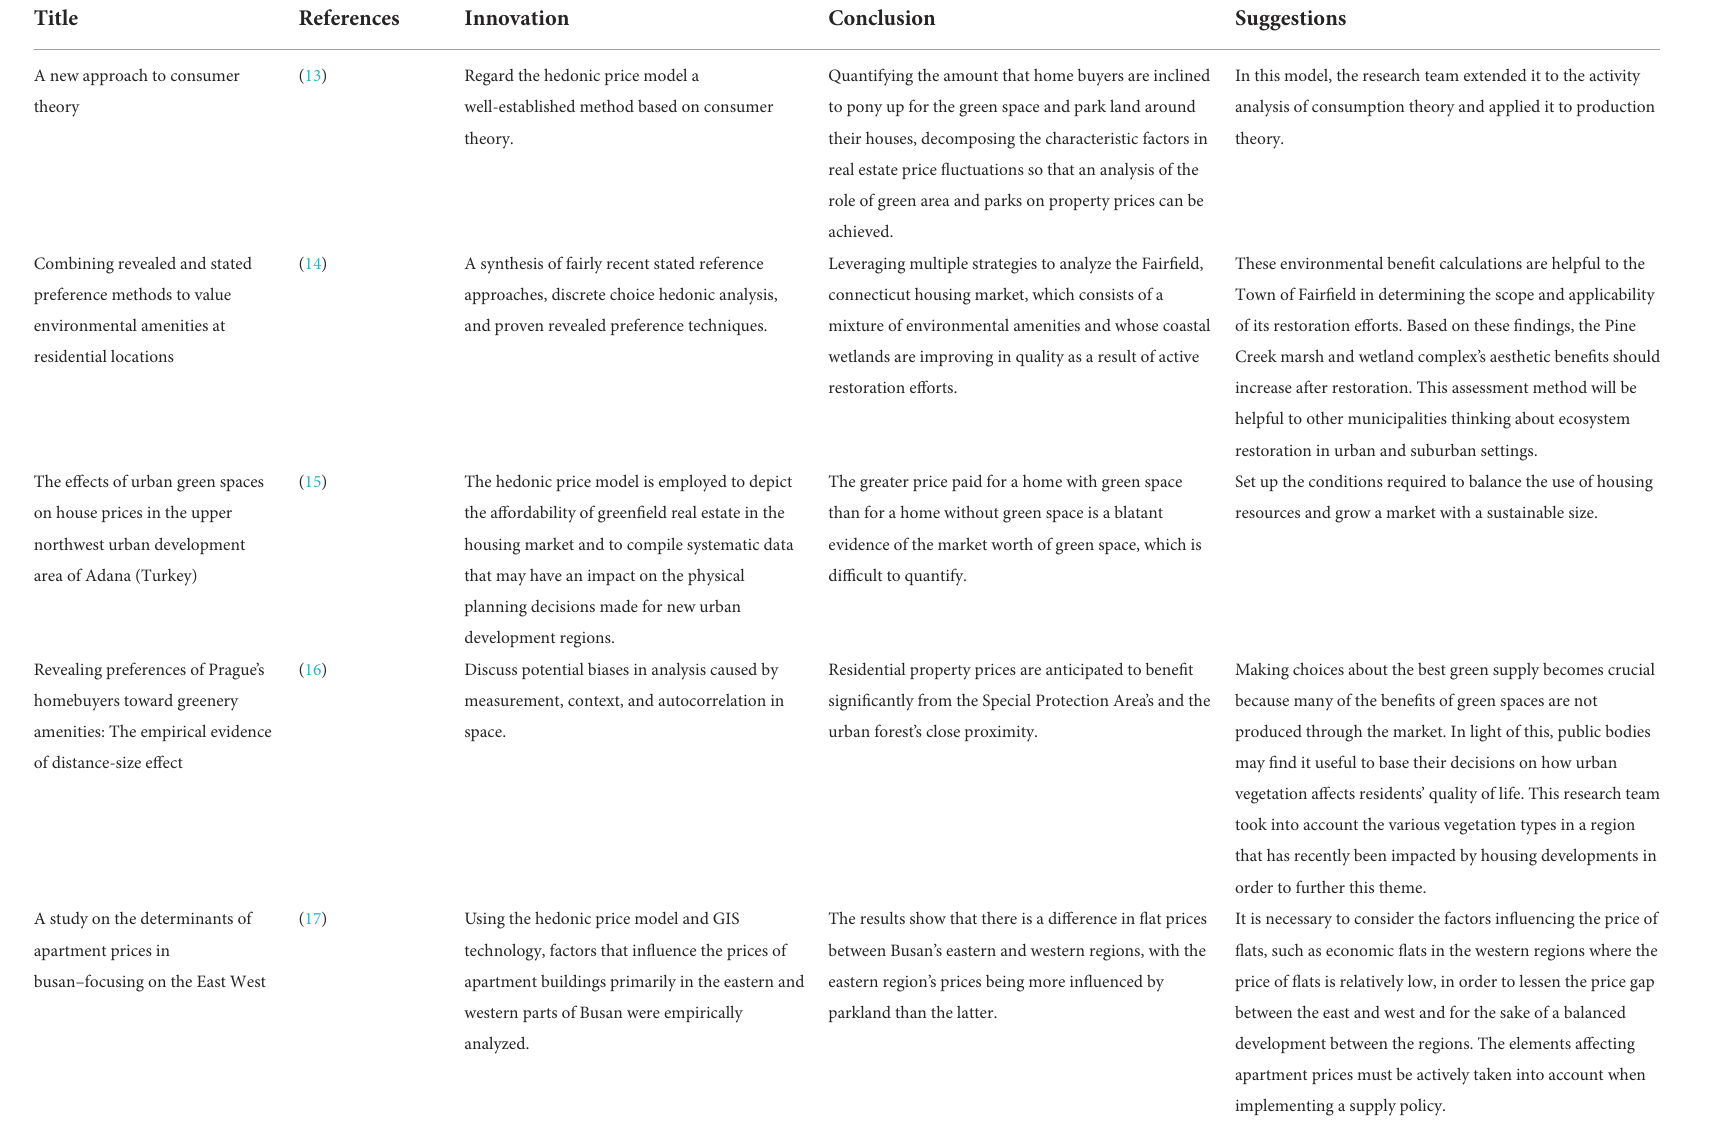
TABLE 1 Literature review of the hedonic price